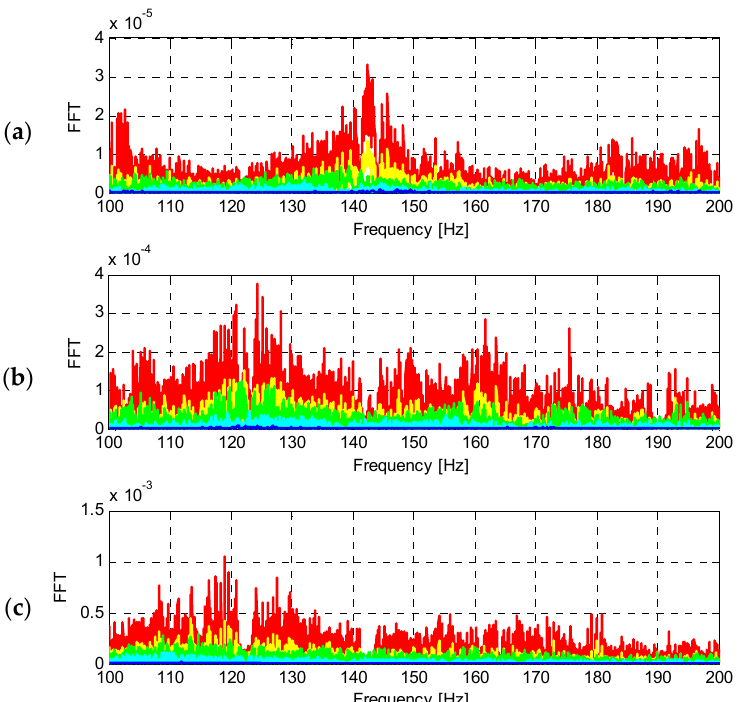
Figure 29. Power spectral density of the results from the additional accelerometers. Material: Sa 3; Isotropic pressure 50 kPa; Frequency spectrum 100–200 Hz; Excitation (torque) amplitude: ( a ) 0.5 V, ( b ) 2 V, ( c ) 4 V (– the top sensor, S1, – the second sensor from the top, S2, – the third sensor from the top, S3, – the fourth sensor from the top, S4, – the bottom sensor, S5).